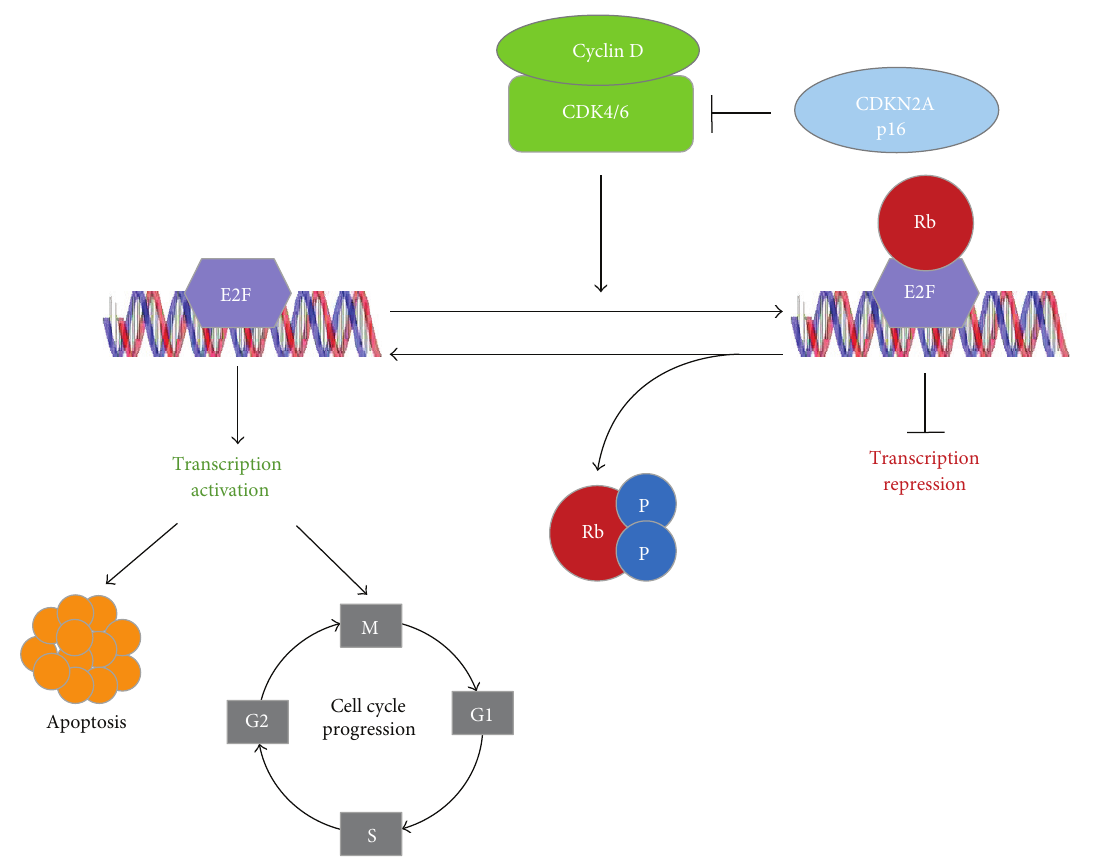
F 5: Signaling mechanism in